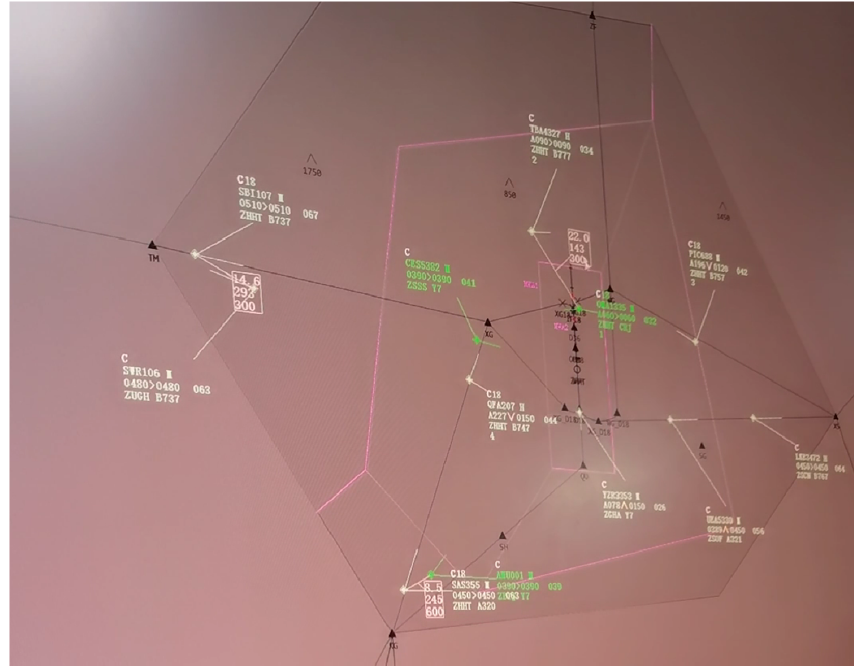
Figure 2. A simplified radar screen of ZHHH SA, Wuhan FIR.